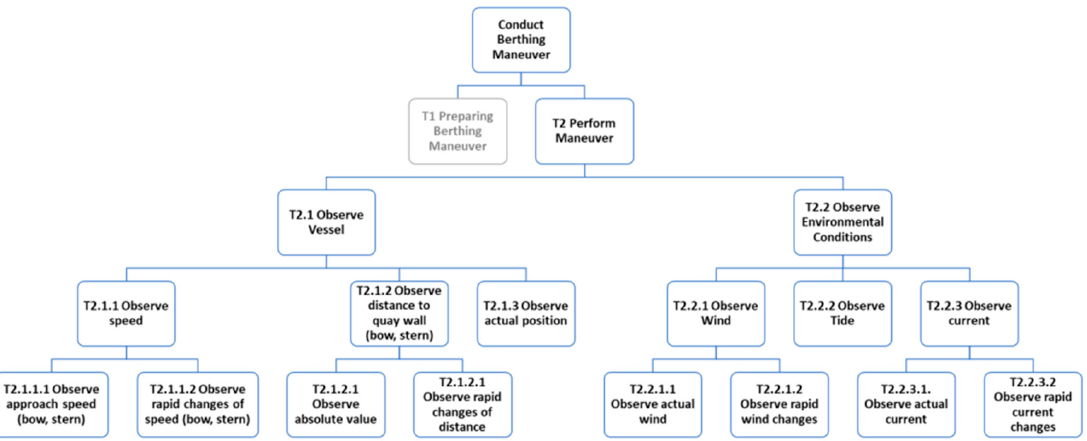
Figure 1. Analysis based on interviews with harbor and river pilots taken and adapted from [15] .